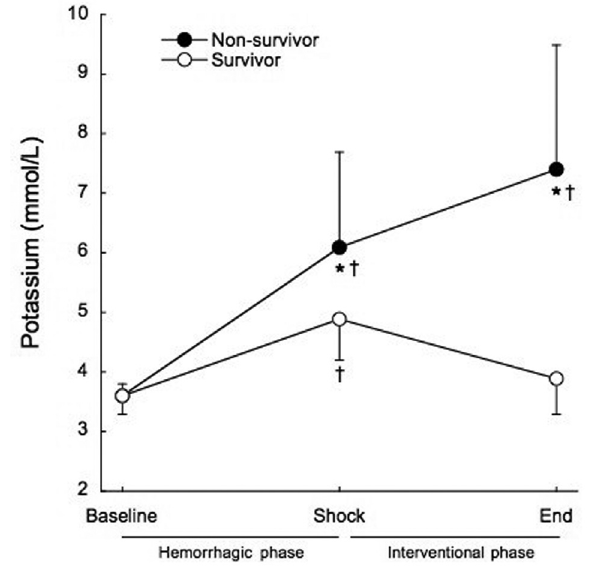
Figure 2 - Mean arterial pressure before treatment at hemorrhagic phase (baseline and shock), and after treatment at 5, 10, 20 and 30 minutes of the interventional phase, in survivors (open circles) and non-survivors (filled circles). * p <0.001 when compared to non-survivors. † p <0.05 when compared to baseline.